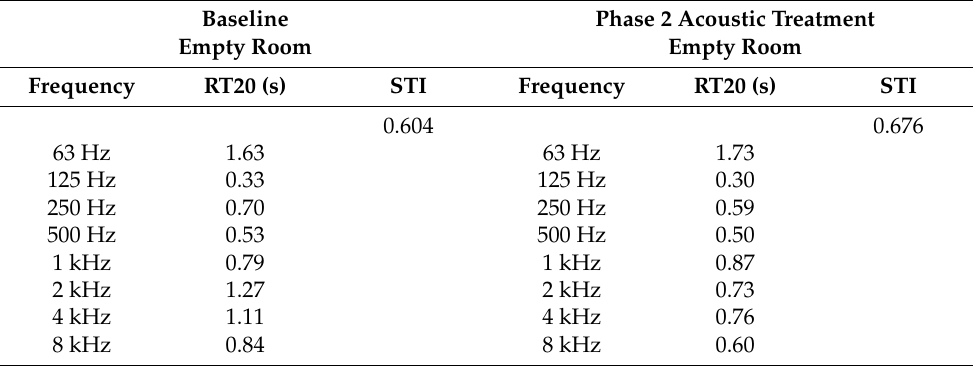
Table A1. Reverberation time (RT20) and speech transmission index (STI) measured in empty room before and after acoustic treatment.